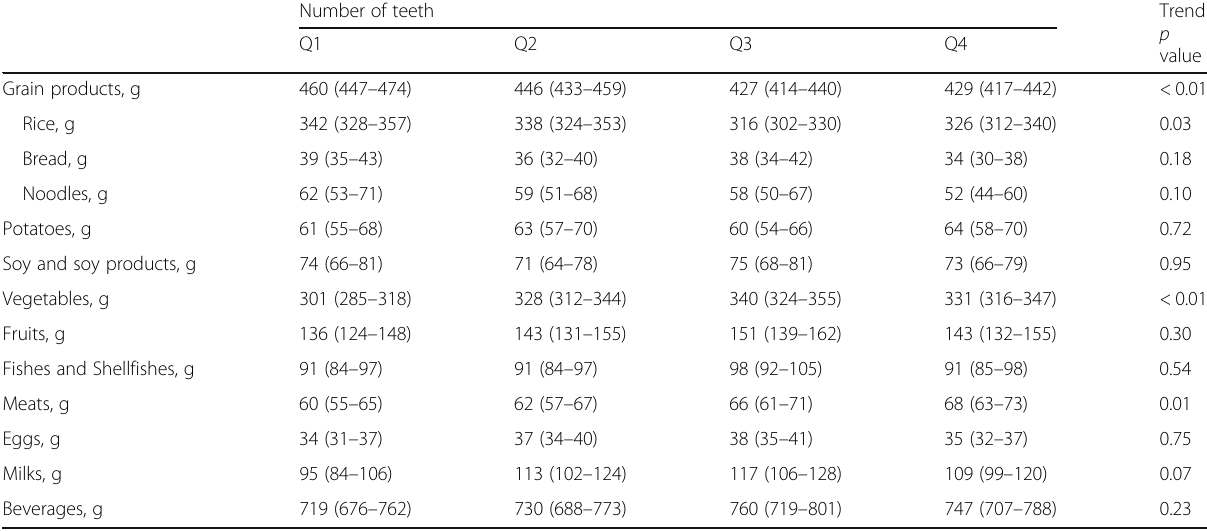
Table 2 Adjusted means of food group intake by the number of teeth (brackets contain 95% confidence intervals) Number of